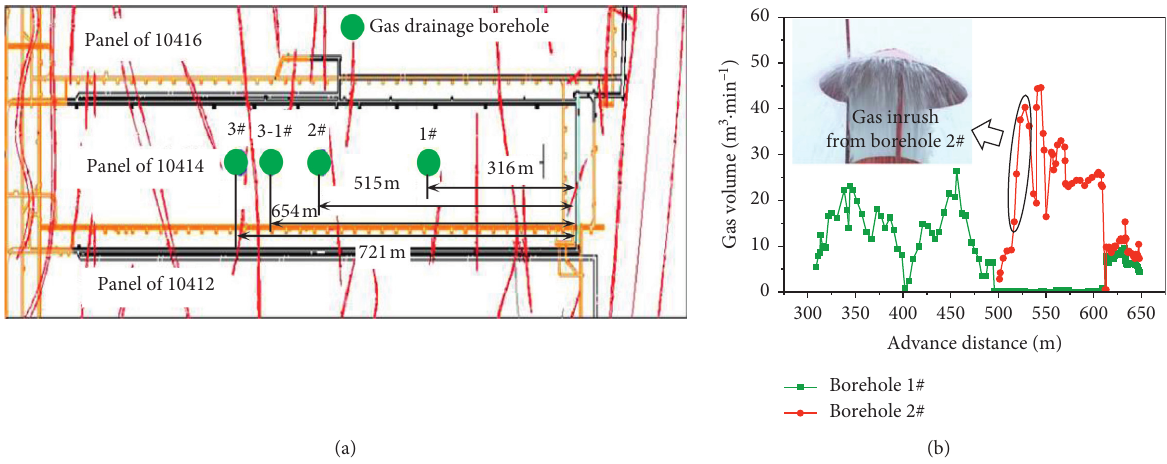
Figure 2: Dynamic accident of gas inrush in panel 10414 [22]. (a) Layout of gas drainage boreholes. (b) Relationship between gas inrush and advance